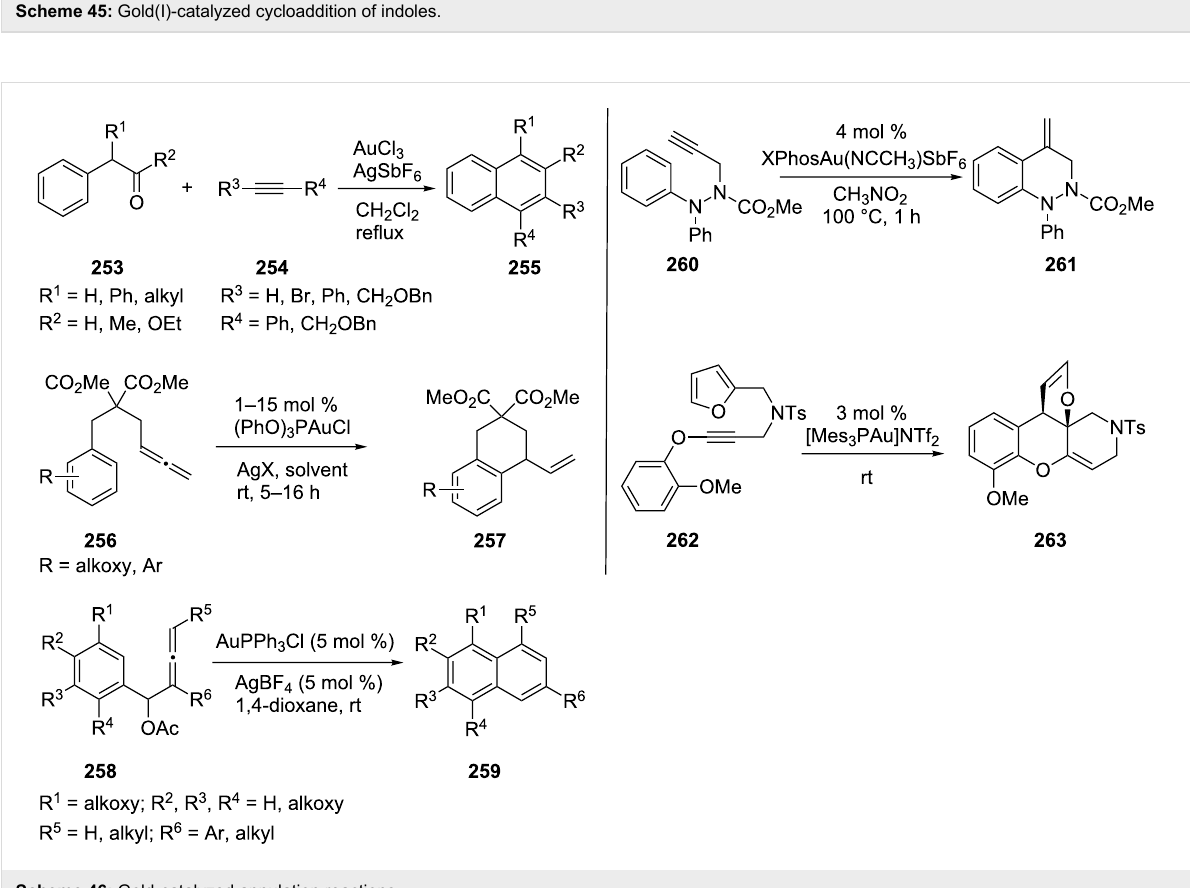
Scheme 46: Gold-catalyzed annulation